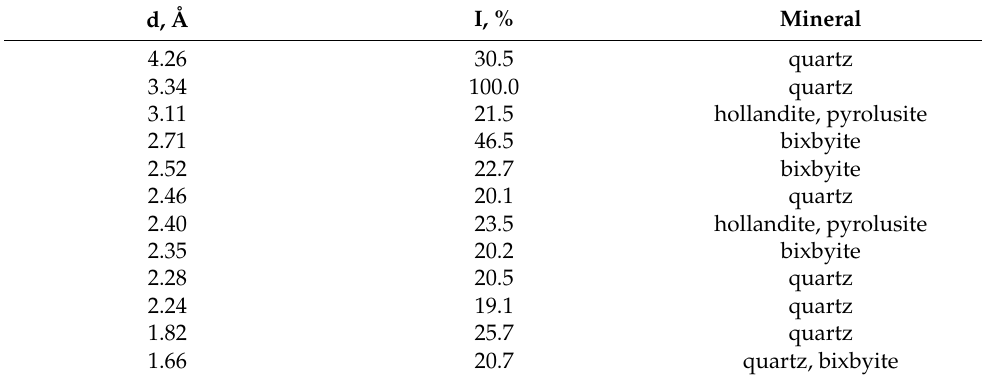
Table 5. Interplanar distances, relative intensities of reflexes, and phase content of manganese ore sample from the Zhaksy deposit.